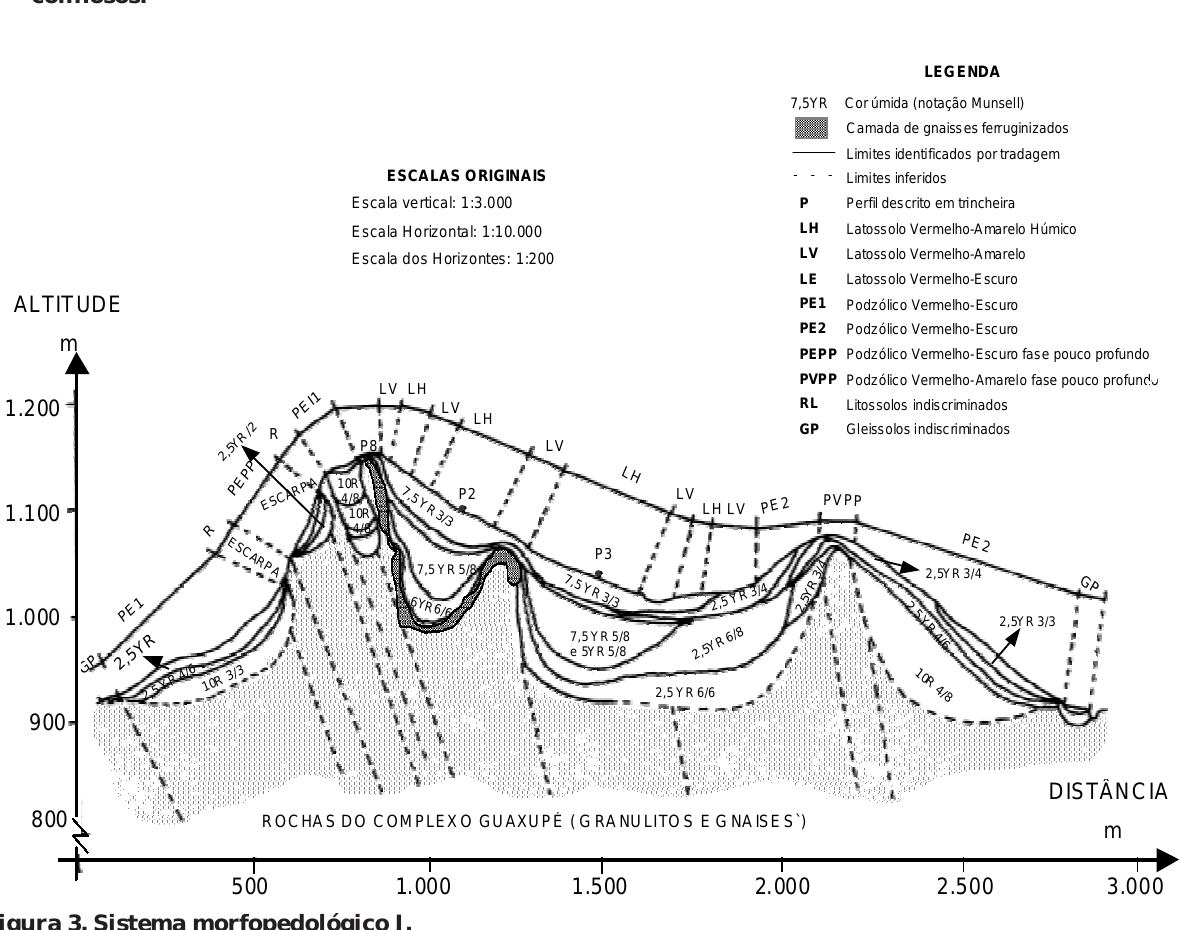
Figura 2. Blocodiagrama da área estudada. (a) vista frontal (b) vista lateral (1) superfície dissecada de topografia montanhosa, onde as cotas são mais elevadas (2) superfície rebaixada de patamares colinosos.